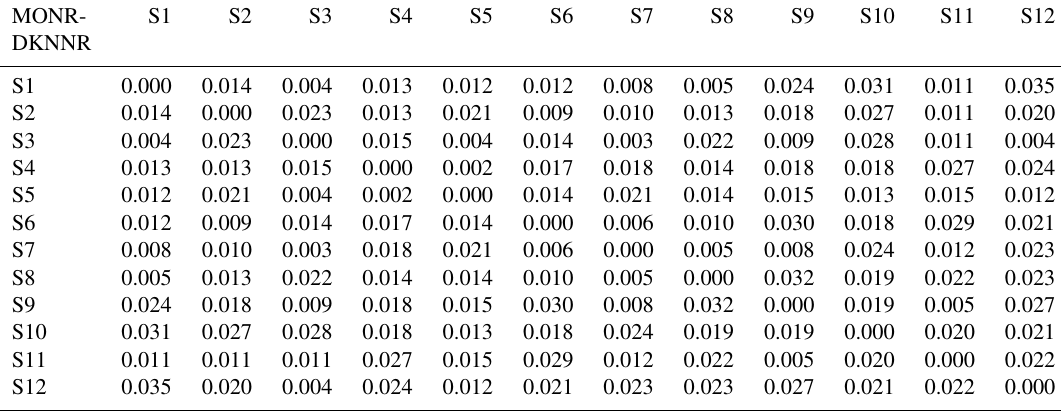
Table 6. The difference of RMSE of cross-correlation between MONR and DKNNR. Note that the positive value indicates that the DKNNR model performs better in preserving the cross-correlation, while a negative value (in bold font) shows that the MONR model performs better. MONR- S1